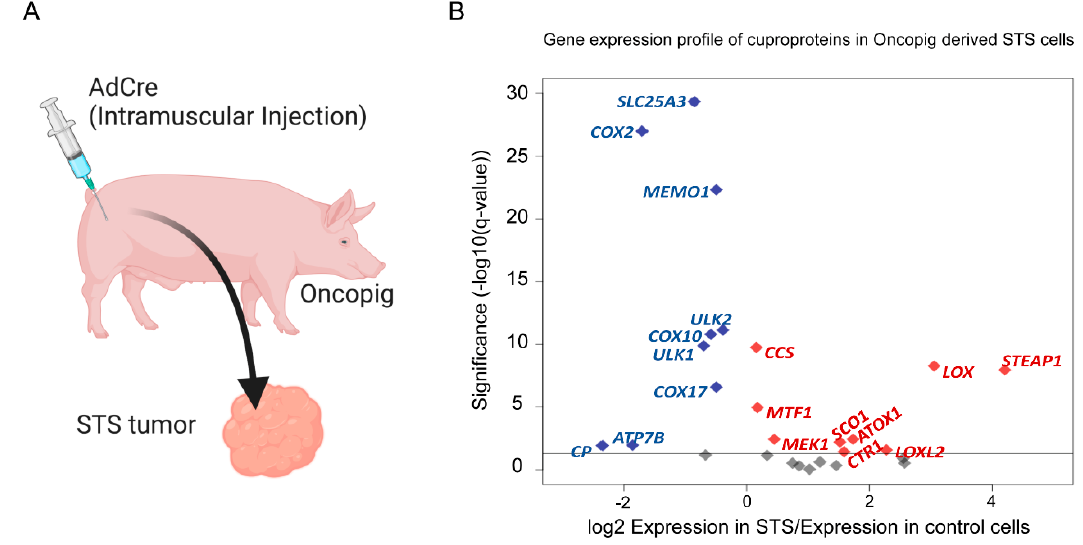
Figure 3. Differential expression of Cu-related genes in Oncopig-derived STS Cells. ( A ) Process to induce Oncopig STS tumors. ( B ) Volcano plot of genes encoding cuproproteins in Oncopig STS cells, plotting magnitude expression difference by significance. The horizontal line represents q-value = 0.05. Red indicates significant upregulation, blue denotes significant downregulation, and grey represents non-significant changes in expression. STS Accession codes: The data sets supporting the results of this review article are available in ArrayExpress accession number: E-MTAB-3382. Figure created in BioRender.com and R software (version 4.0.3) [125].